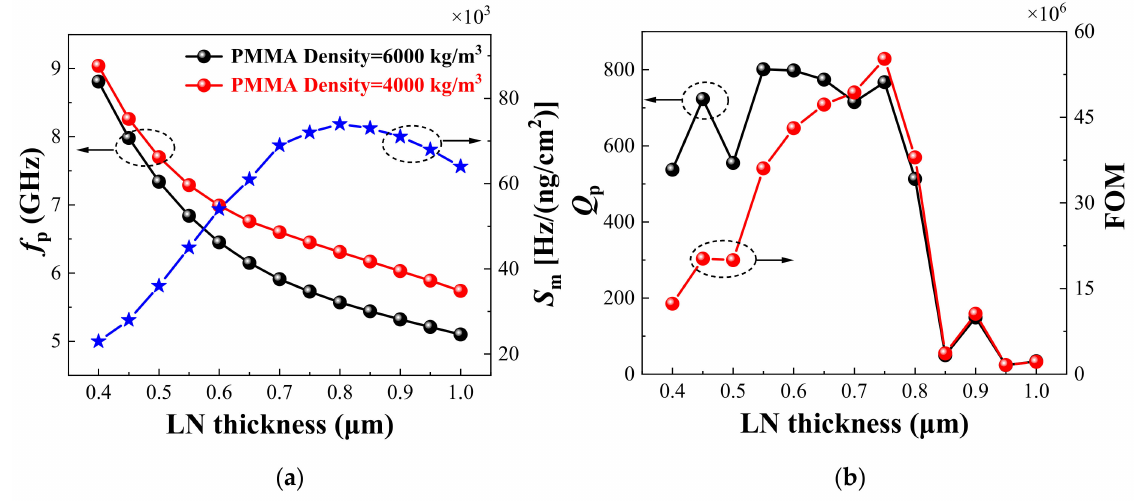
Figure 6. Influence of LN film thickness on ( a ) f p , S m , and ( b ) Q p , FOM of